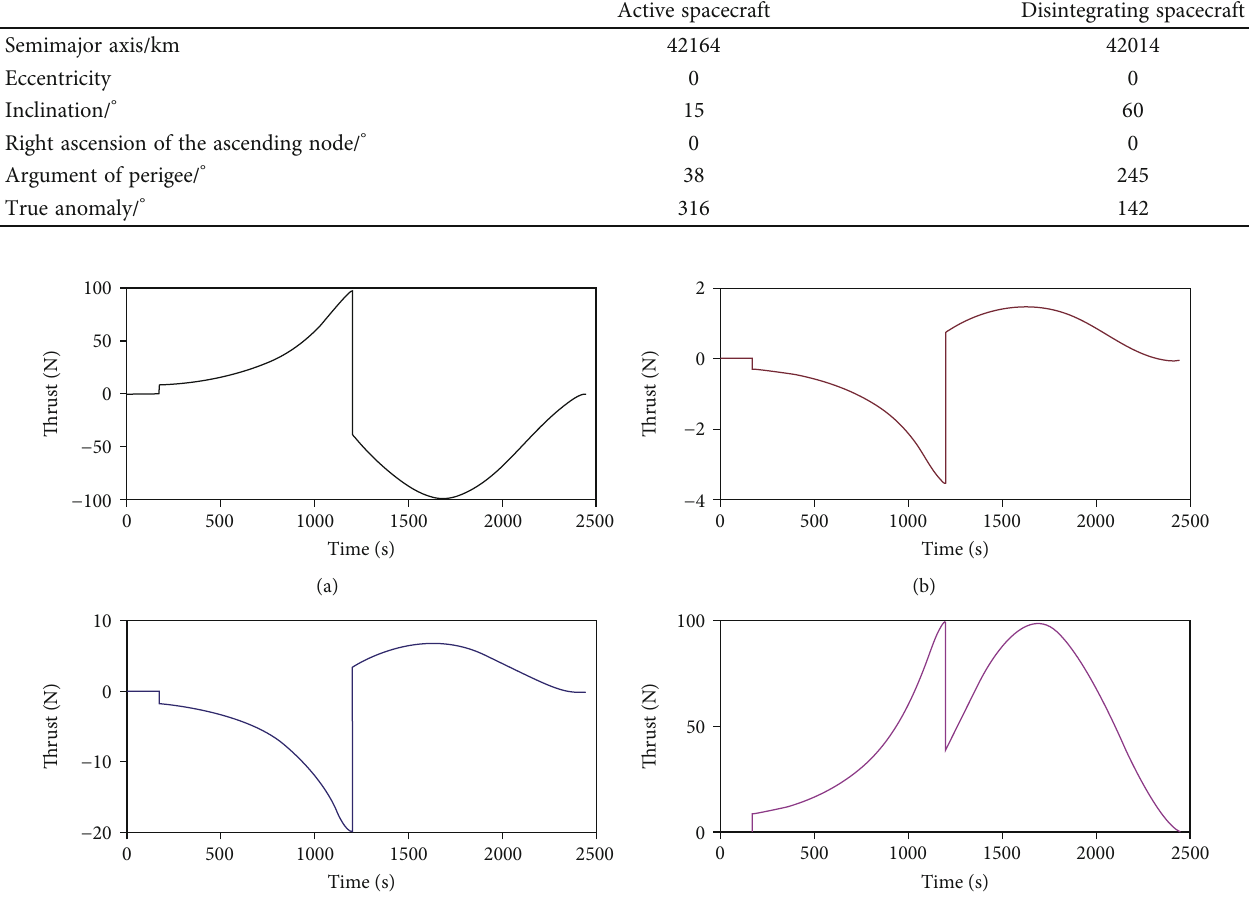
Table 2: The six elements of initial moment active spacecraft and disintegrating spacecraft disintegrating moment orbit.